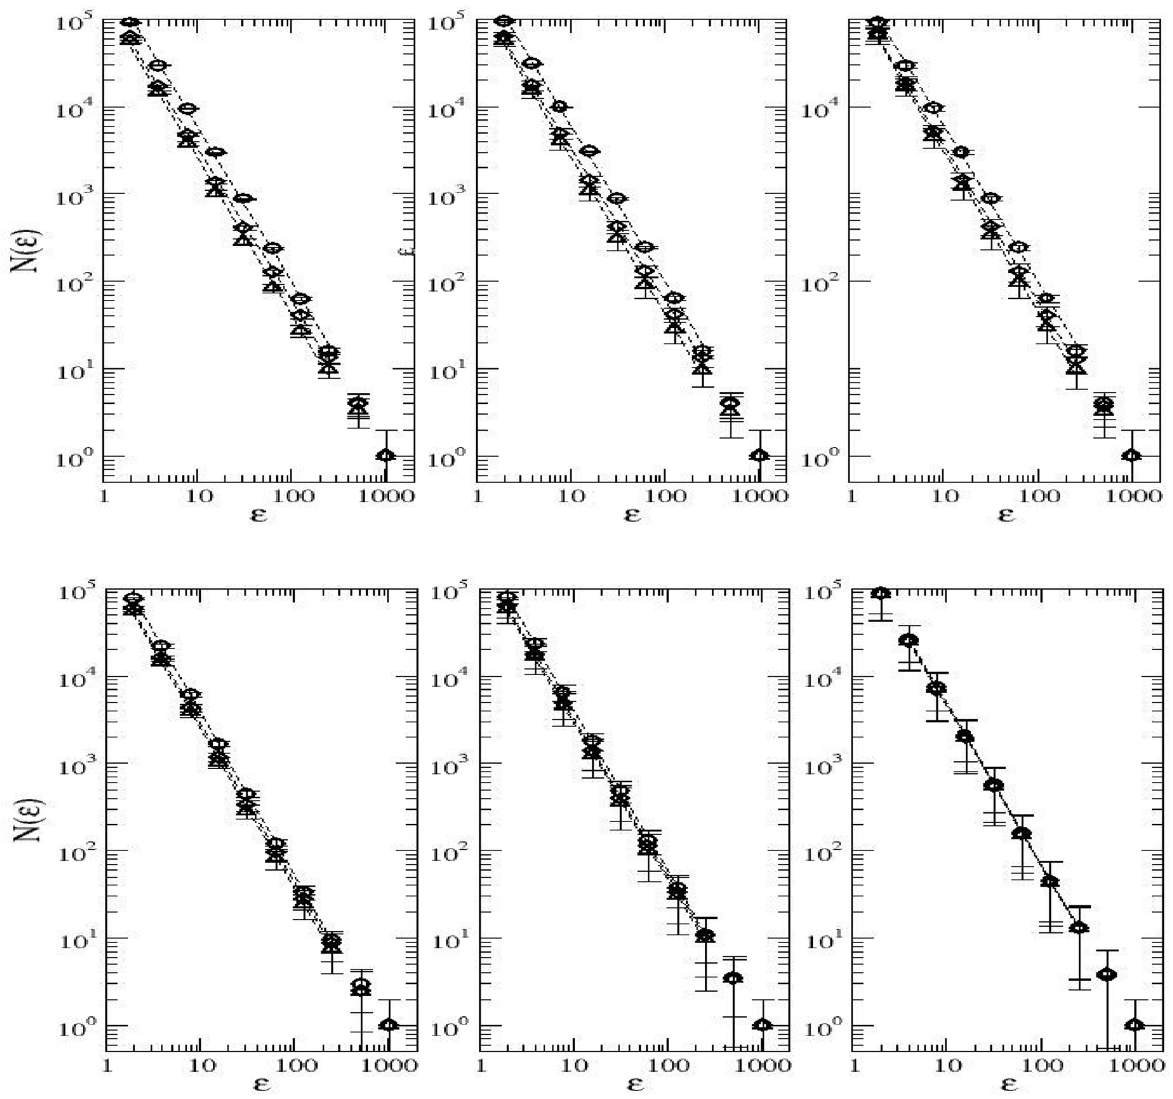
Figure 5. Measurement of the fractal dimension D r of the spatial distribution of the commonest species. N ( E ) versus E . The parameter values are L ~ 1024 , speciation rates n ~ 1 | 10 { 4 (left panels), n ~ 1 | 10 { 5 (middle panels), n ~ 1 | 10 { 6 (right panels). In the upper panels the fraction of suitable habitats is set at p ~ 0 : 3 , whereas in the lower panels p ~ 0 : 7 . The symbols denote different values of H : H ~ 0 : 1 (circles), H ~ 0 : 5 (diamonds) and H ~ 0 : 9 (triangles). The data points represent an average over 20 independent runs. The error bars correspond to one standard error.